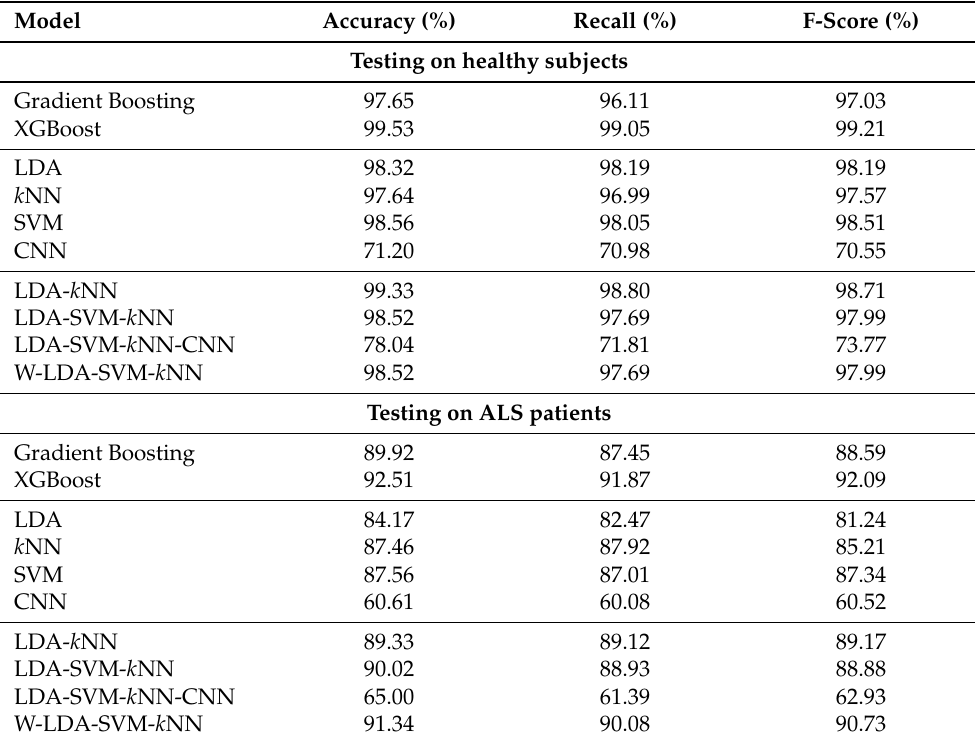
Table 4. Test results using 4-channel